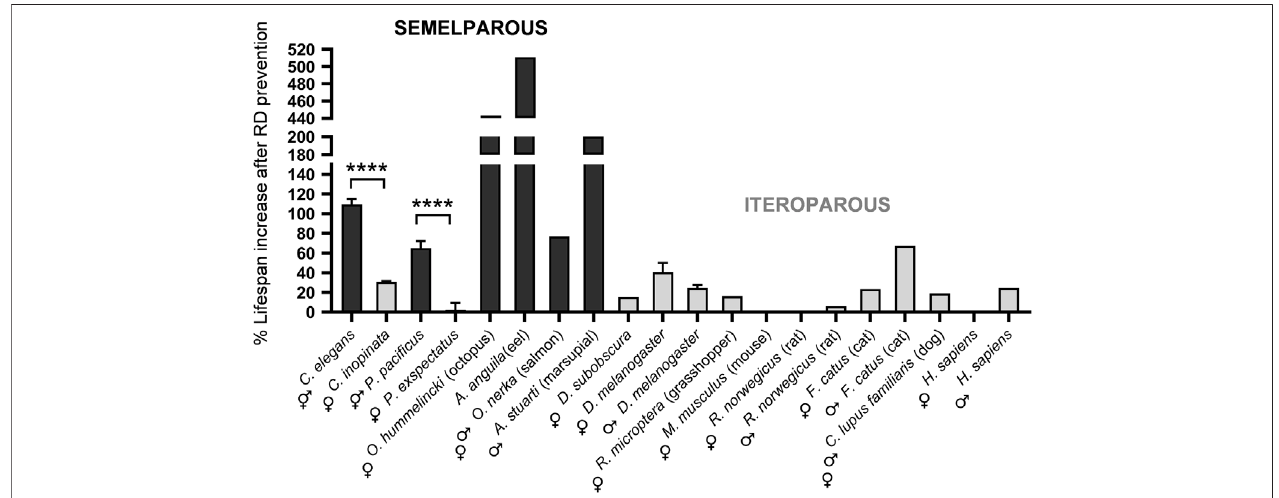
FIGURE2| Blockingreproductivedeathinsemelparousspeciesstronglyincreaseslifespan,whilegonadectomyiniteroparousspeciesoveralldoesnot.Effectson lifespanofgermlineablationinhermaphroditebutnotfemalenematodesofseveralspeciesresembleeffectsofblockingreproductivedeathinsemelparousspecies(Kern etal.,2021).Valuesfornematodesfromarecentreport(Kernetal.,2021),andforotherspeciesfromarecentreview(Gemsetal.,2021);wheretherearemultiplestudies of the same species, only references with both male and female data are included, and for A. anguila (eel) data from the more recent source (Tesch, 1977).